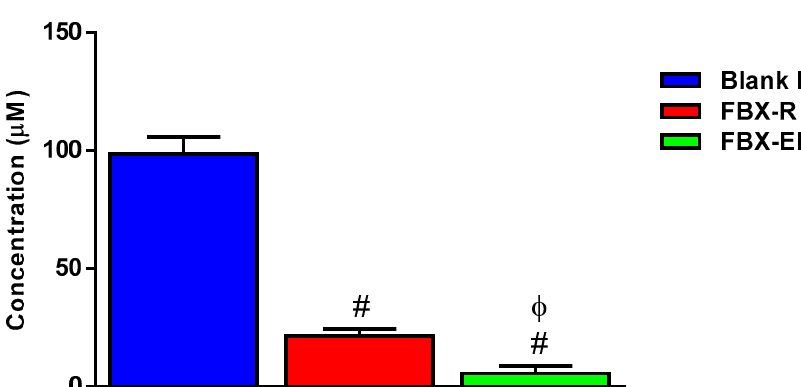
Figure 4. IC50 of the Blank EMLs, FBX-R, and FBX-EMLs in the HCT 116 cells. Data are the mean of 4 independent experiments ± SD. # Significantly different vs. Blank EMLs ( p < 0.05); Φ Significantly different vs. FBX-R ( p < 0.05).